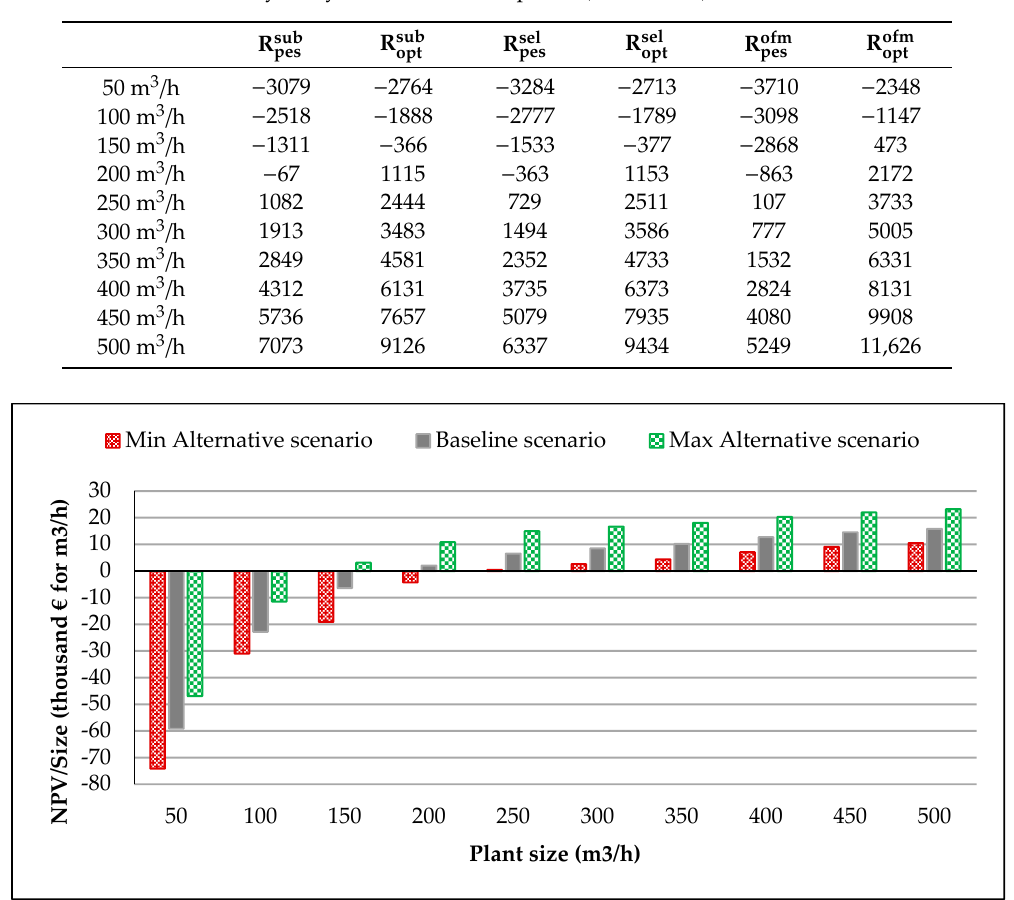
Figure 5. NPV/size (thousand € for m 3 /h)—baseline and alternative scenarios. Figure 5. NPV / size (thousand € for m 3 / h)—baseline and alternative